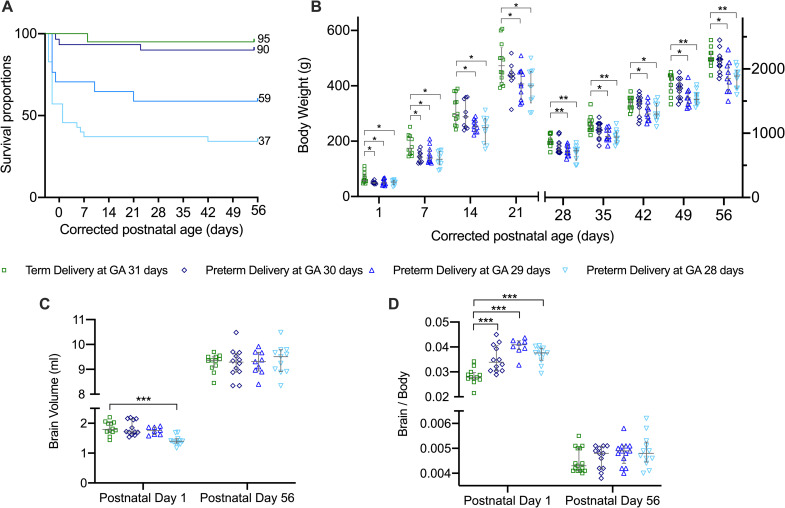
Rabbits survival and biometrics.New-born rabbit survival (A), body weight (B), brain weight (C) and brain to body ratios (D). PCA31d n = 12, PCA30d n = 12, PCA29d n = 9 and PCA28d n = 11. Data displayed as median and IQR with significance compared to the term birth group indicated as * 0.05 ≥ p > 0.01; ** 0.01 ≥ p > 0.001; ***p < 0.001.